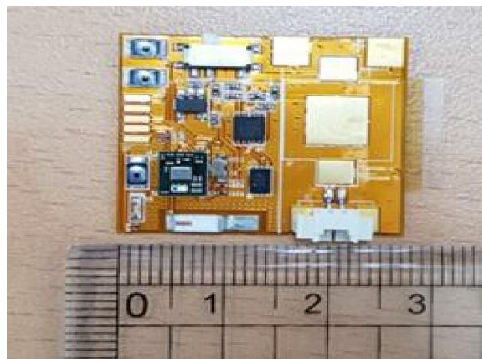
Figure 4. Sensor circuit (enlarged view) .